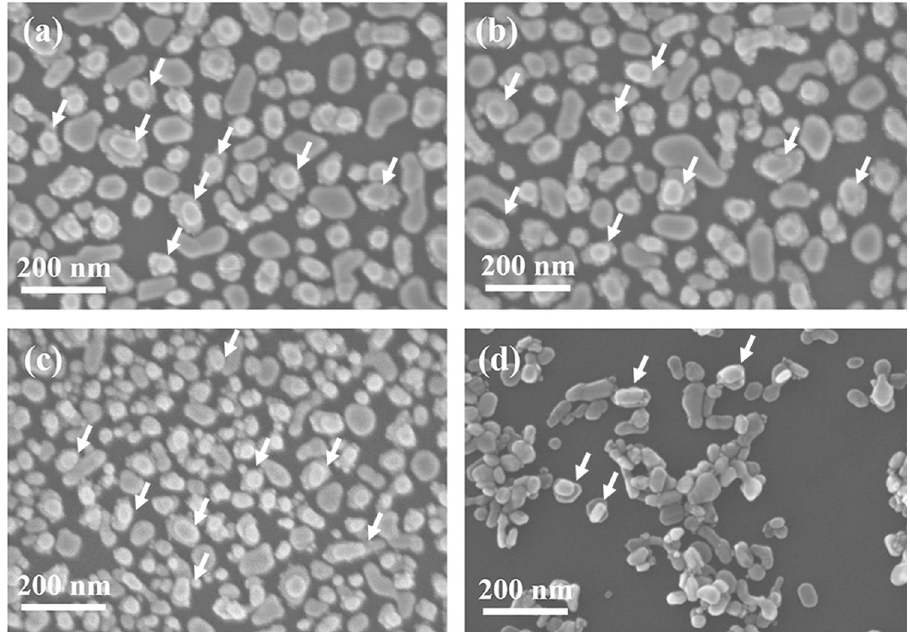
Figure 6. FE-SEM images of Au NPs/nanogap/Au NPs structure with ( a ) 30 s, ( b ) 90 s, ( c ) 120 s and ( d ) 300 s KOH etching.